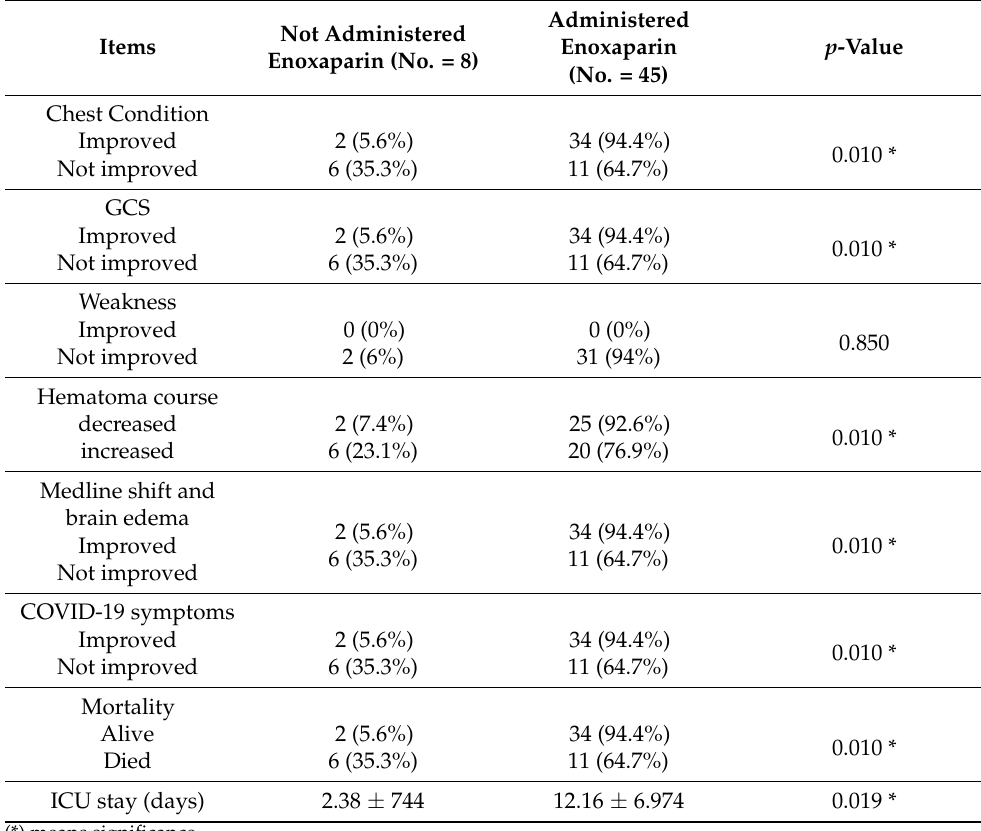
Table 6. Relations between enoxaparin and the outcome of the study (presentations, mortality, and ICU